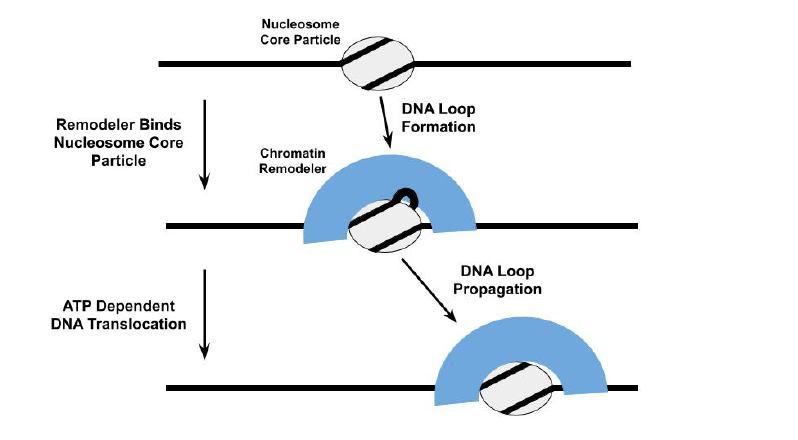
Figure 3. One model proposed for the repositioning of the nucleosome core particle involves the formation and propagation of DNA loops [49,53,65,67,87,88]. The propagation of these DNA loops relies upon the ability of the chromatin remodeler to translocate the nucleosomal DNA relative to the histone